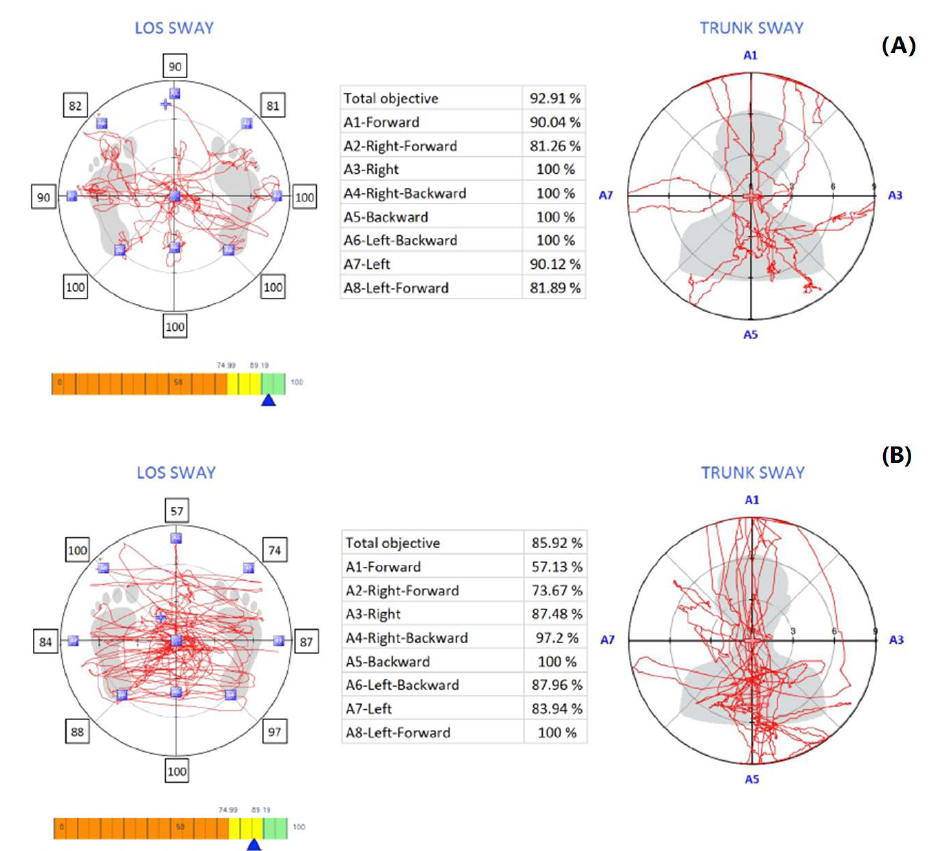
Figure 5. Limits of stability and trunk sway in ( A ) asymptomatic and ( B ) fibromyalgia syndrome